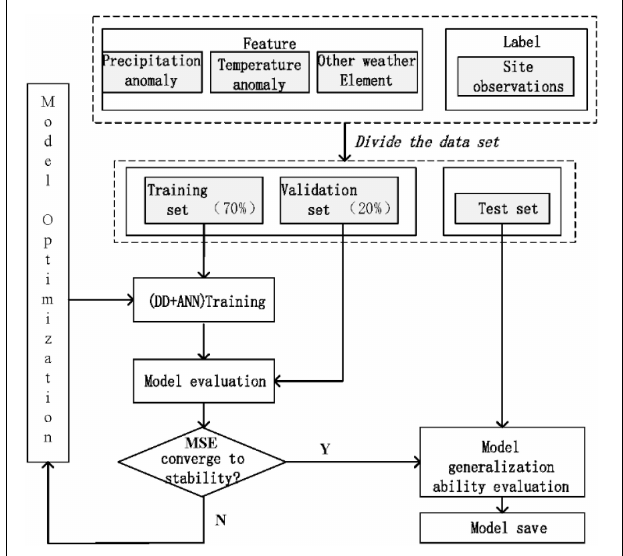
FIGURE 4 | Flowchart of summer precipitation correction algorithm based on artificial dendrite